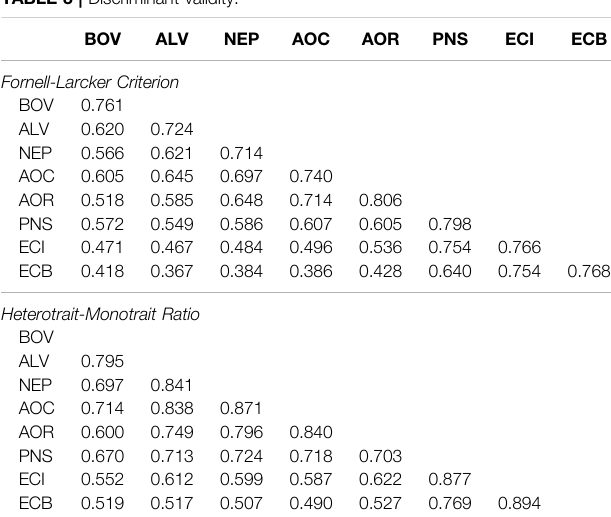
TABLE 3 | Discriminant